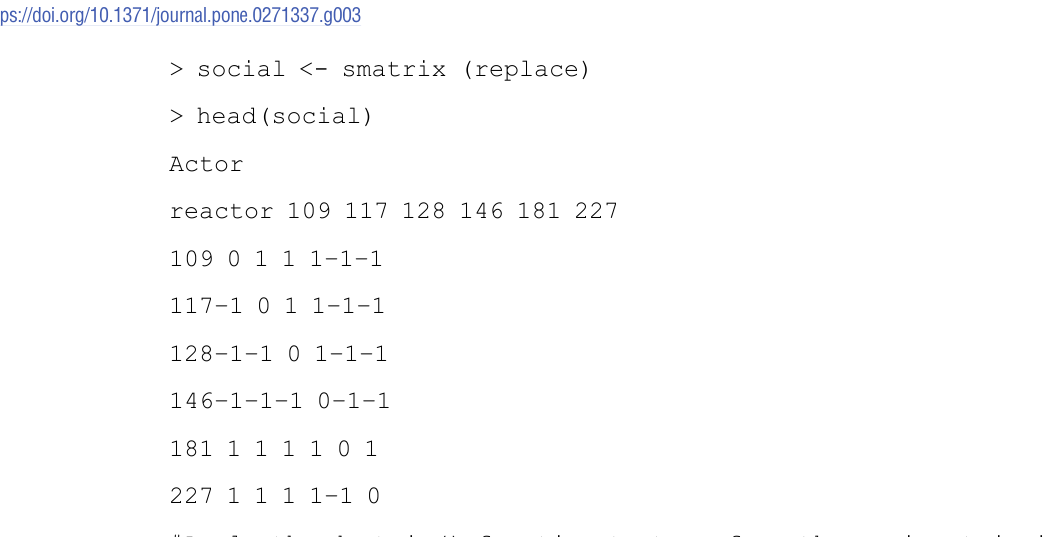
Fig 3. Example of the output data frame of the (a) smatrix() function and (b) dmatrix()